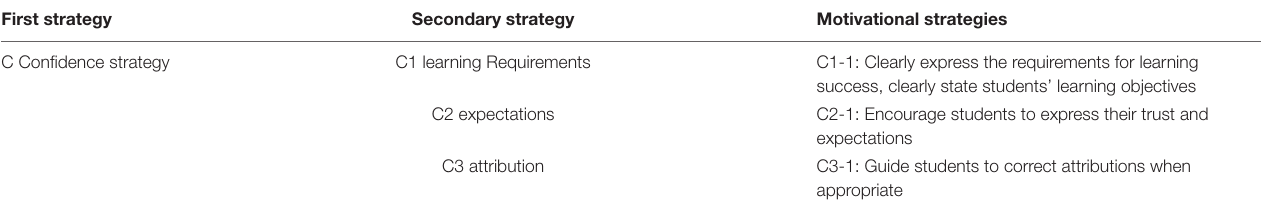
TABLE 3 | Confidence strategy coding system after